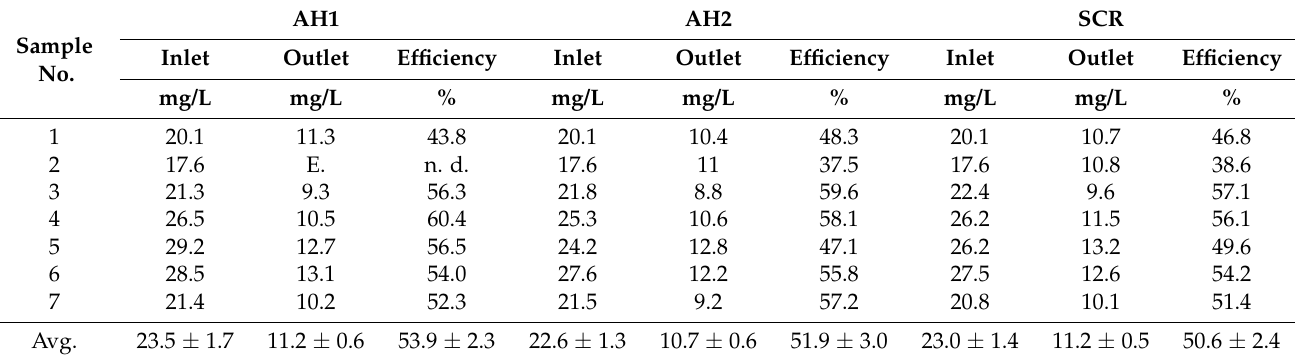
Table 4. Inlet and outlet P tot and removal efficiencies at stage I.